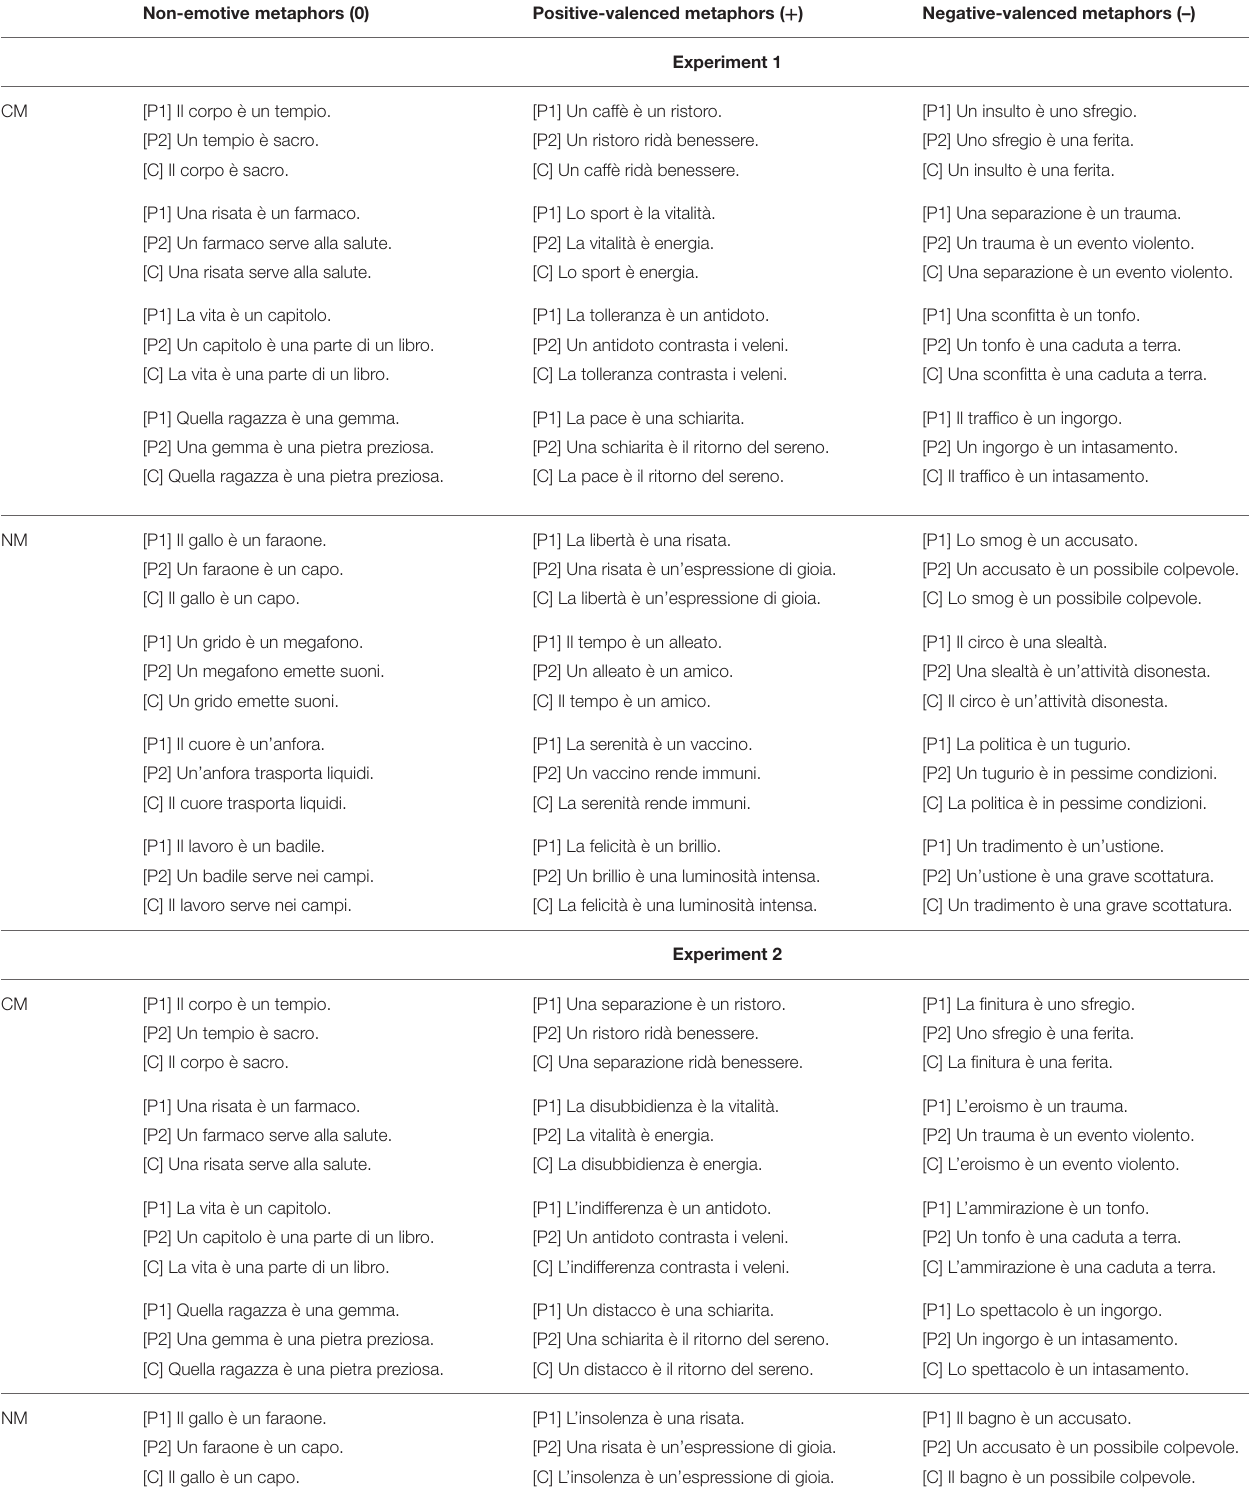
TABLE A2 | Table of materials in Italian for each middle term condition in Experiment 1 and Experiment 2. Non-emotive metaphors